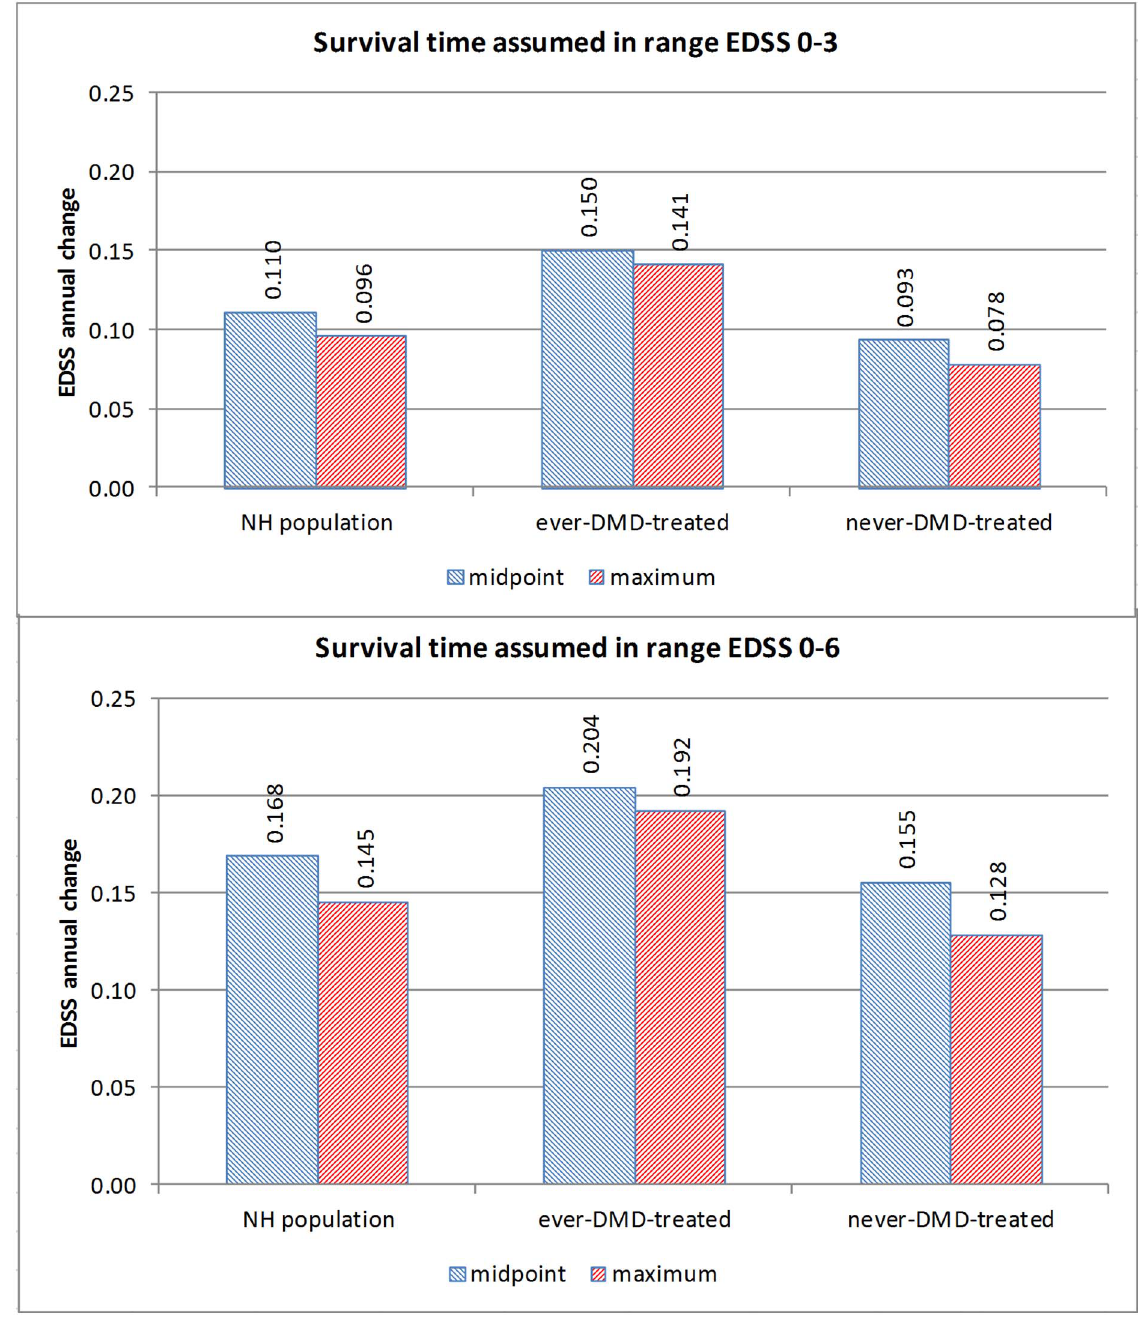
Figure 3. Fixed effects model estimates of disability progression per year in relapsing-onset MS natural history patients, by study groups and time periods, assuming midpoint or maximum survival time, Nova Scotia, 1979–2010. Footnote: EDSS=Expanded Disability Status Scale.